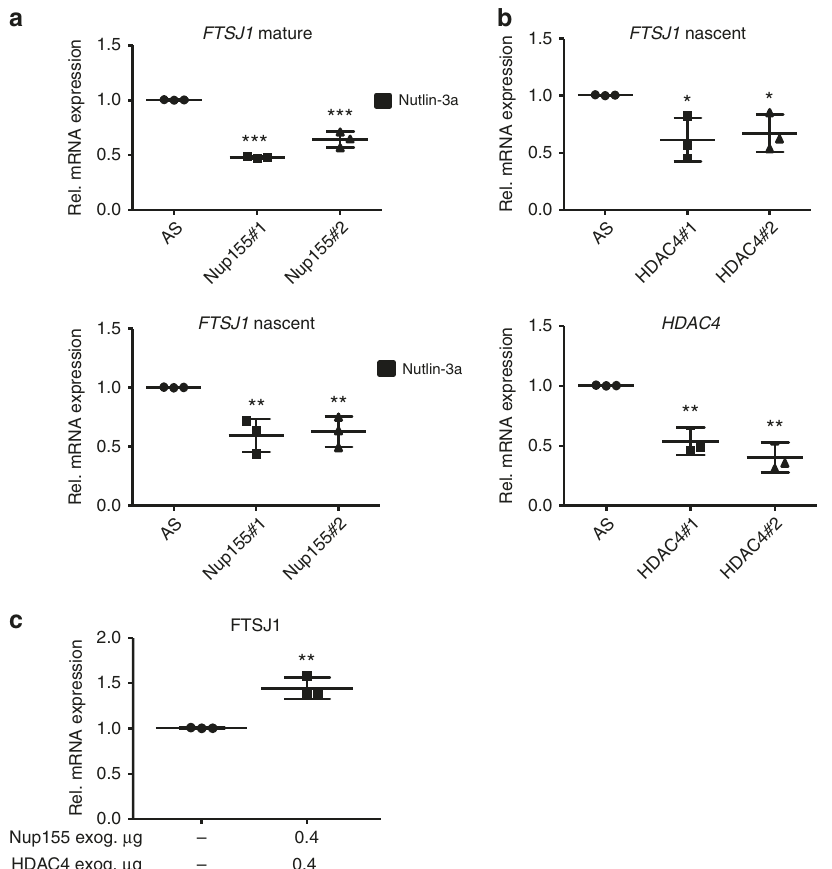
Fig. 5 HDAC4 is involved in FTSJ1 transcriptional regulation. a Relative mature (upper panel) and nascent (lower panel) mRNA levels of FTSJ1 in HepG2 cells upon Nup155 knockdown and Nutlin-3a treatment for 24 h as measured by qRT-PCR. Data are derived from three independent experiments and normalised to the control siRNA condition. b HepG2 cells were treated either with control siRNA (AS) or two different HDAC4 siRNAs (HDAC4#1 and HDAC4#2) for 72 h and p53 was induced by adding Nutlin-3a for 24 h. Relative nascent mRNA levels of FTSJ1 (upper panel) and HDAC4 (lower panel) as measured by qRT-PCR. Data are derived from three independent experiments and normalised to the control siRNA (AS) condition. c HepG2 cells were co- transfected with HDAC4 -Flag and Nup155 -HA constructs for 24 h. Empty vector control ( − ). Relative FTSJ1 mRNA level as measured by qRT-PCR. Data are derived from three independent experiments and normalised to the control vector condition. * p < 0.05, ** p < 0.01, *** p < 0.001 (Student ′ s t -test); Data are presented as mean ± stdv. Source data are provided as a Source Data fi